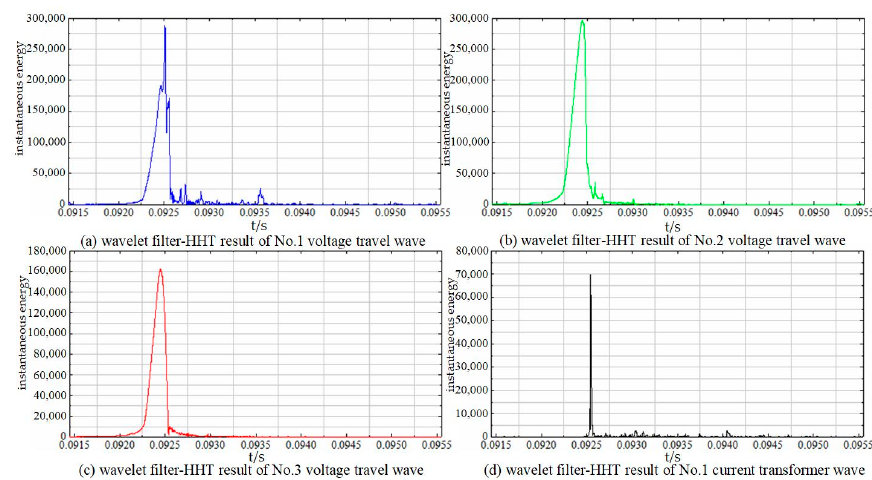
Figure A6. Results of wavelet filter HHT transform in condition 3.